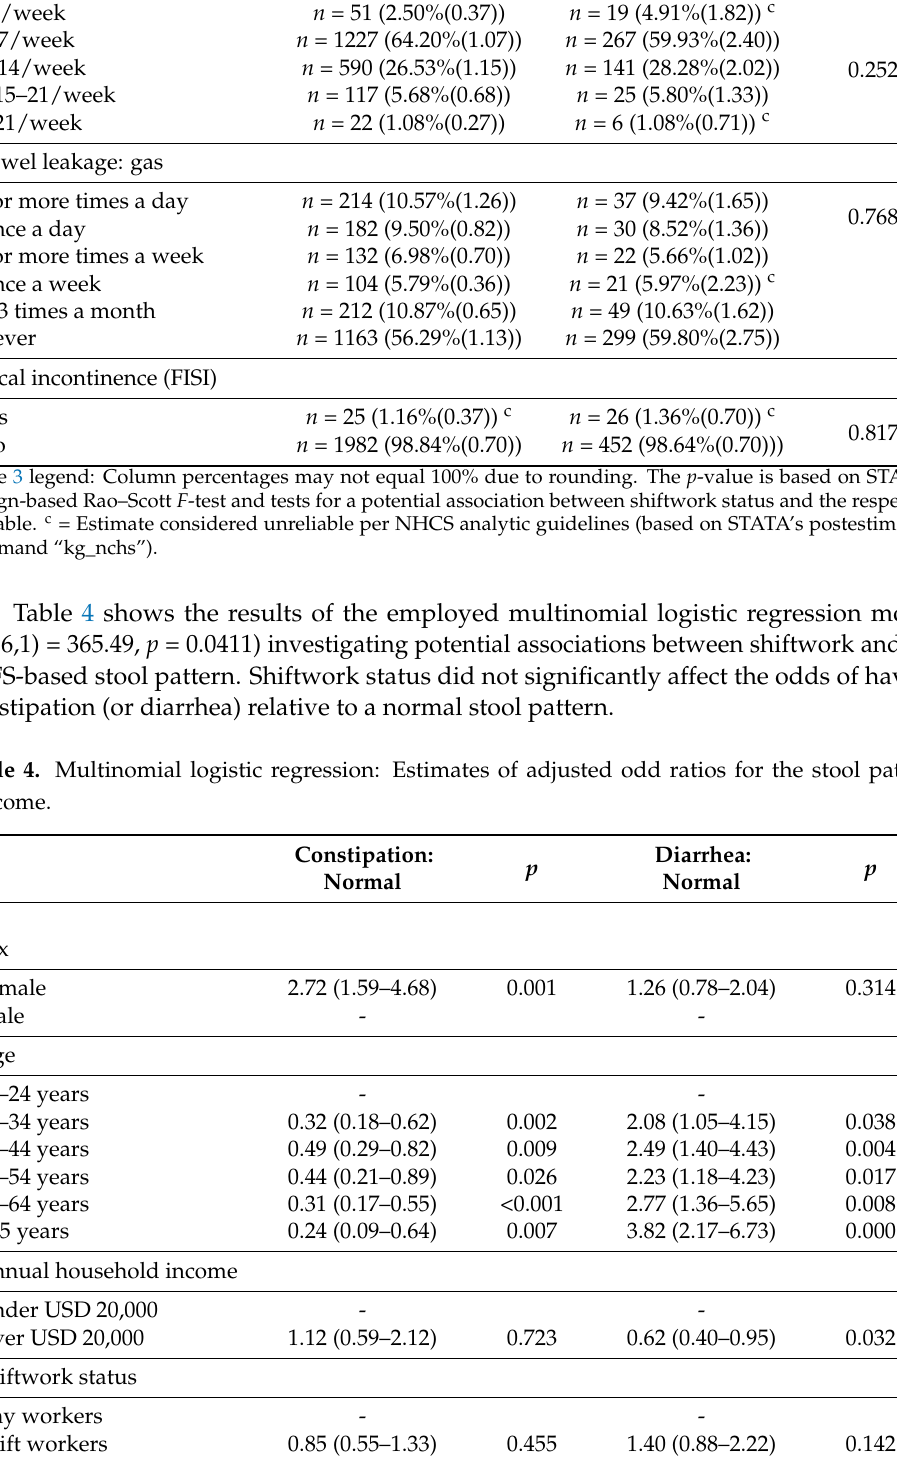
Table 4 legend: OR are displayed with their 95% confidence intervals and p -value. The symbol “-” indicates the reference category. p = p